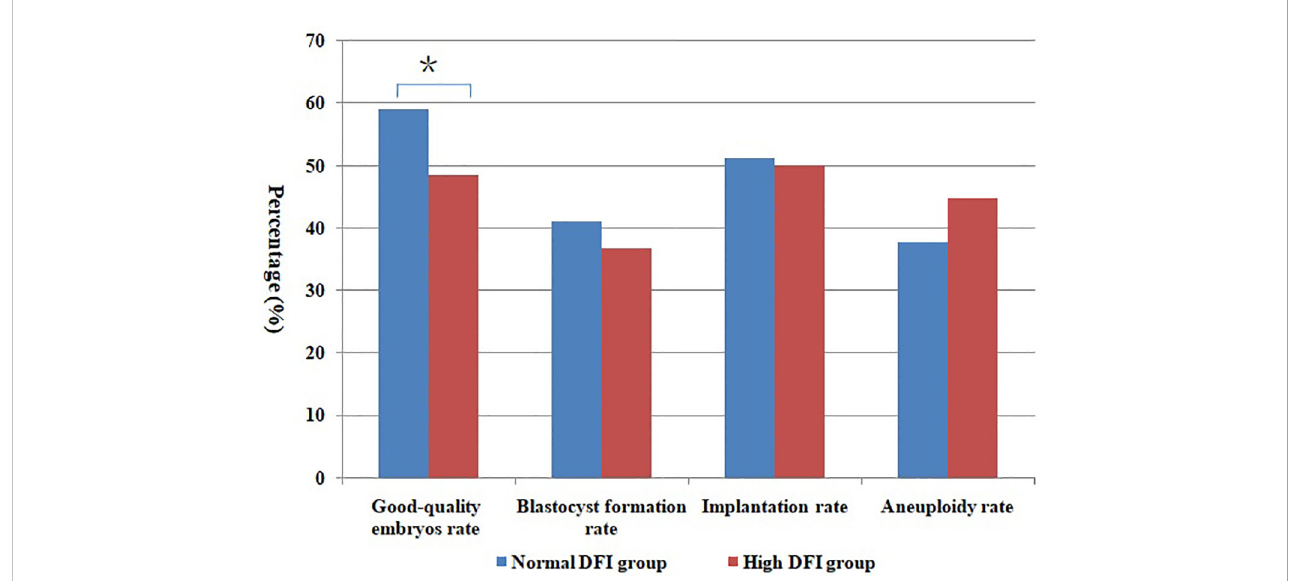
FIGURE 2 Comparison of different rates between normal DFI and high DFI group. *Statistically signi fi cant (P < 0.05).